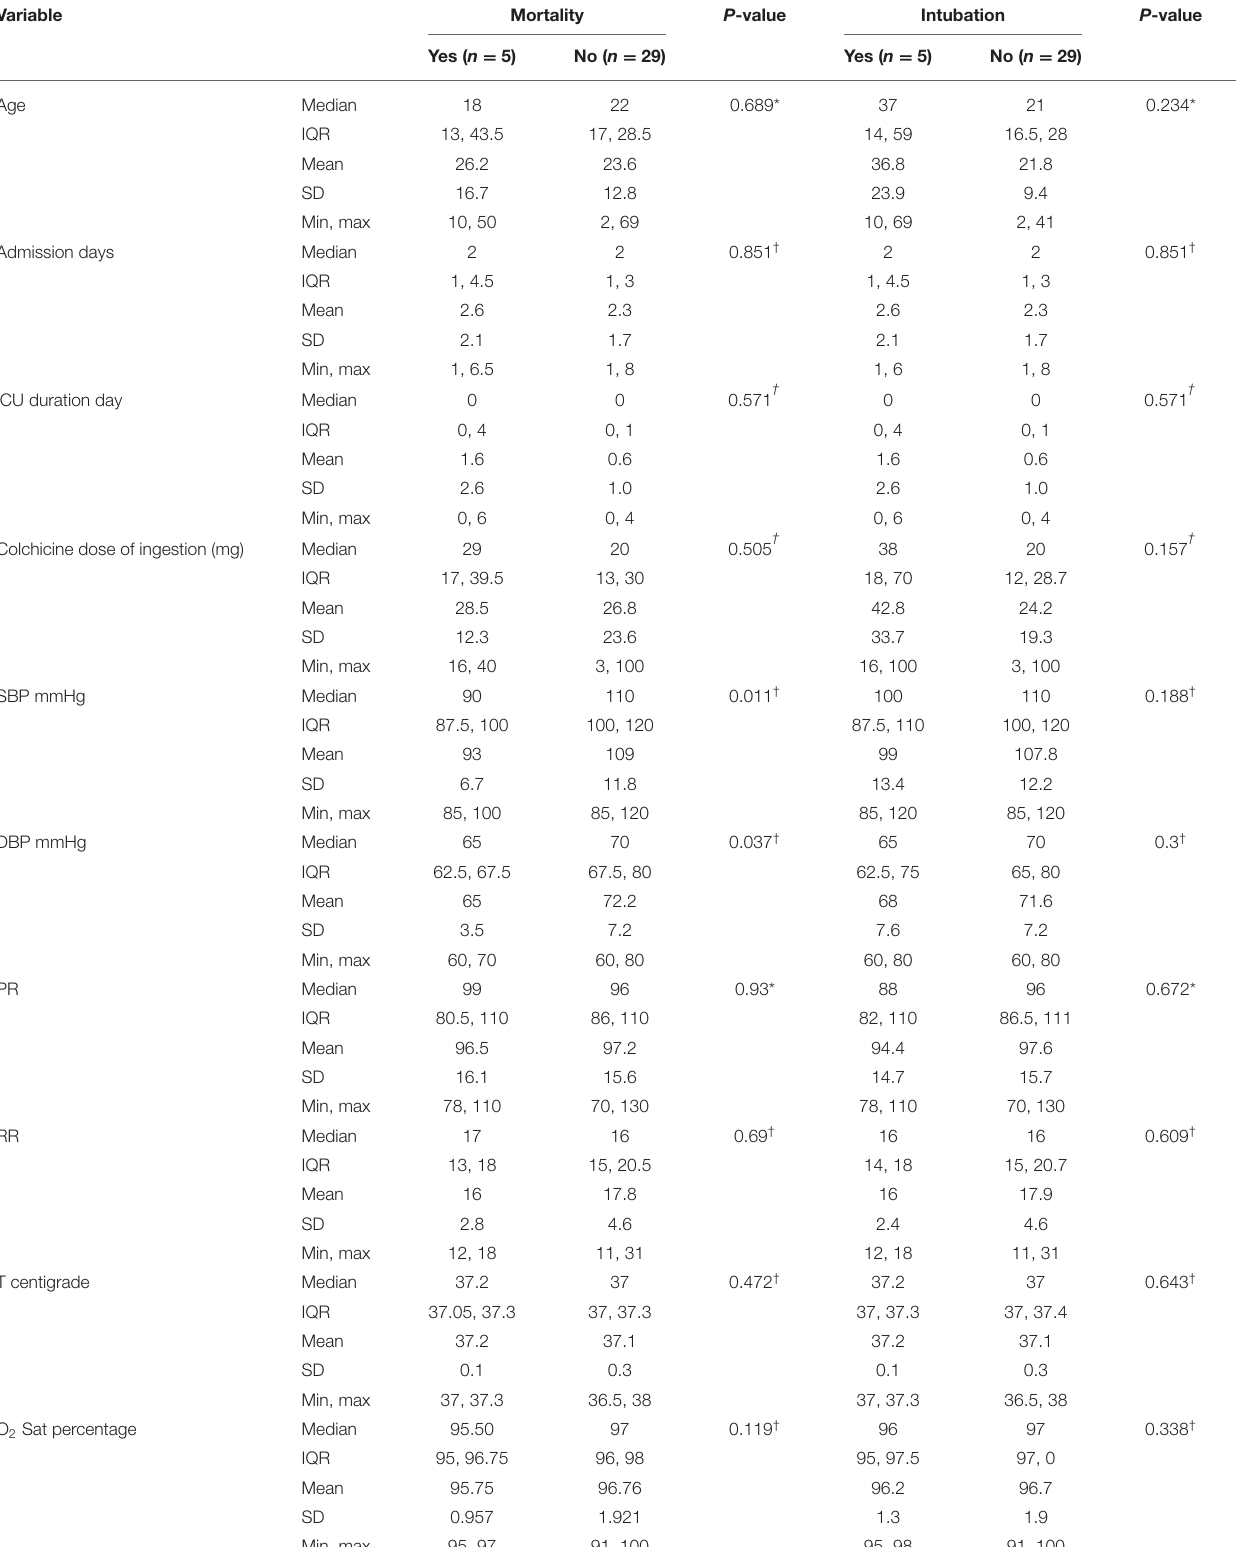
TABLE 3 | Patient history and primary vital signs in mortality and intubation groups. Variable Mortality P